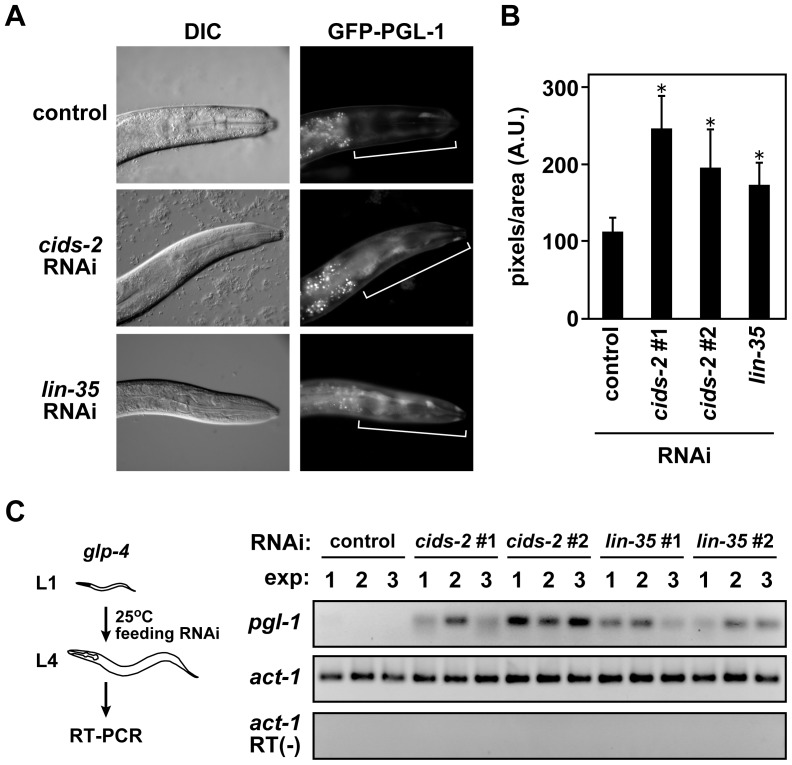
Cids-2 downregulates the expression of PGL-1 in C. elegans somatic cells.(A) Differential interference contrast (DIC, left raw) and fluorescent (right raw) images of C. elegans (bnIs1[pie-1p::gfp::pgl-1]) fed E. coli. that carry a plasmid for control, cids-2, or lin-35 RNAi. GFP signals in the head regions (white brackets) were elevated in cids-2 and lin-35 RNAi worms. (B) The bar graph shows the calculated signal intensity of control, cids-2, or lin-35 RNAi (mean ± S.D., arbitrary units). The GFP signals of cids-2 and lin-35 RNAi animals were significantly increased compared to control RNAi worms. *p<0.001, compared to control RNAi. (C) Knockdown of cids-2 led to the accumulation of the authentic pgl-1 transcript. (left) A schema of pgl-1 RT-PCR analysis. Synchronized glp-4(bn2) mutant worms at L1 stage were fed E. coli. that carried a plasmid for control, cids-2, or lin-35 RNAi and were grown to the L4 stage at the restrictive temperature (25°C). RNAs were then prepared from these L4 animals and subjected to RT-PCR. (right) RT-PCR analysis of the endogenous pgl-1 mRNA was performed with three independent samples for each of the RNAi-treated groups, and act-1 was used as a control. RT (-), no reverse transcription.